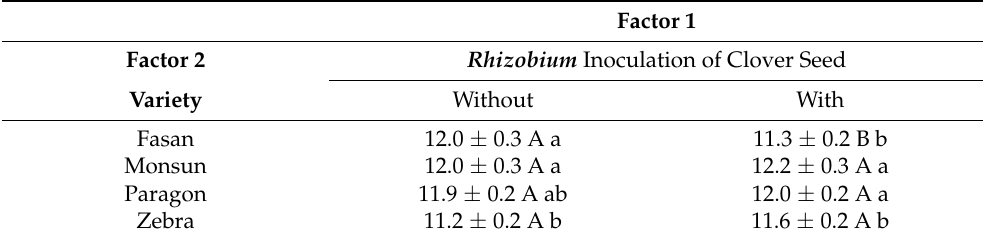
Table 12. Interaction means for effect of Rhizobium inoculation of clover seed and wheat variety on the concentration of protein (%) in wheat grain grown after clover